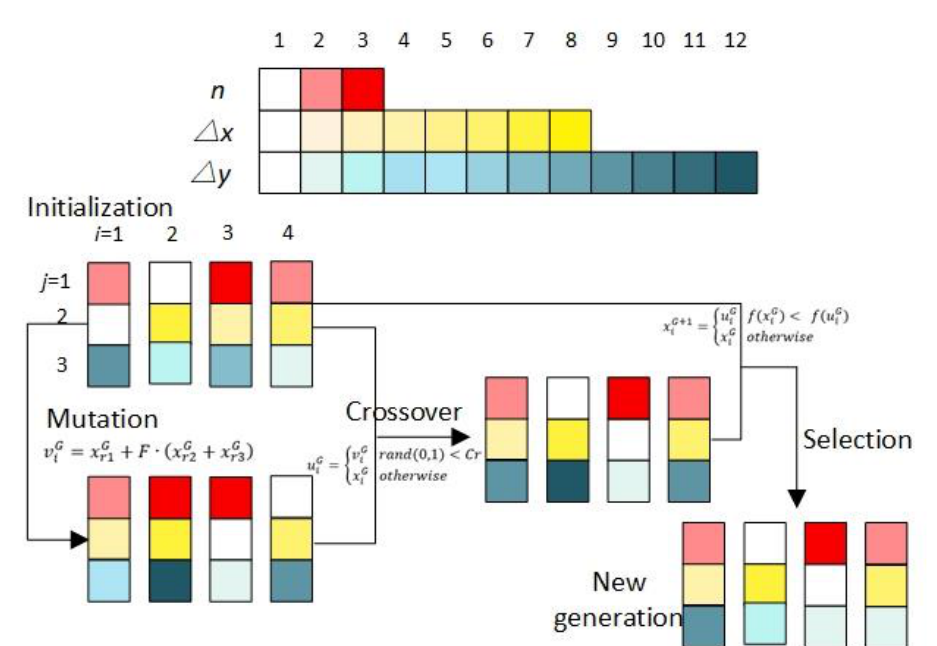
Figure 2. A schematic illustration of DE algorithm.